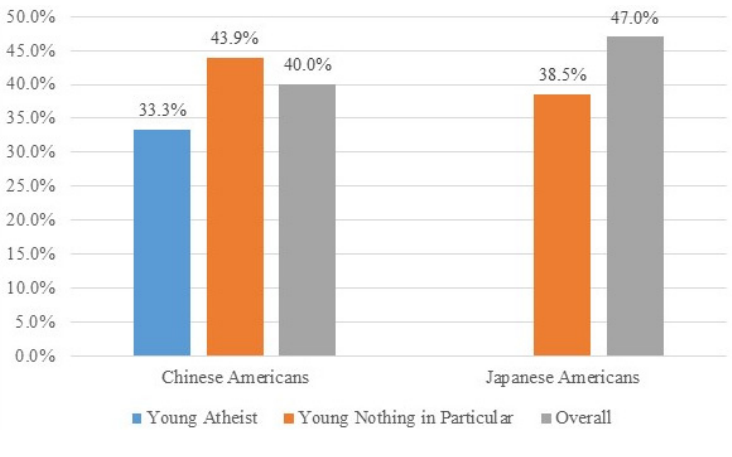
Figure 7. Belief in ancestral